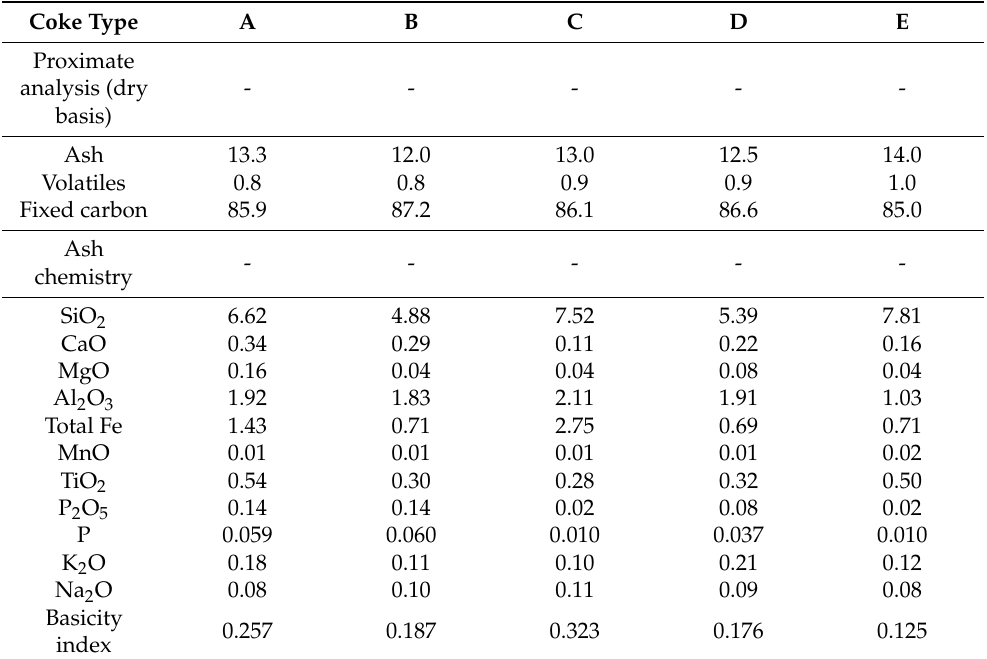
Table 4. Proximate and ash chemical analysis of coke produced from the pilot ovens (% by